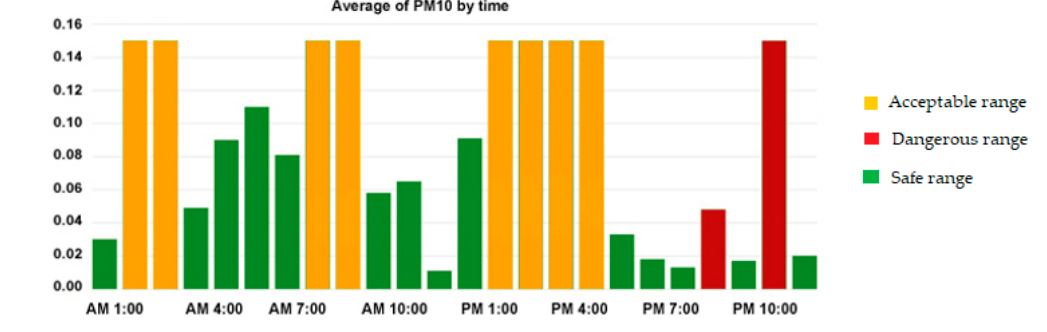
Figure 8. The safe levels of PM 10 over time.